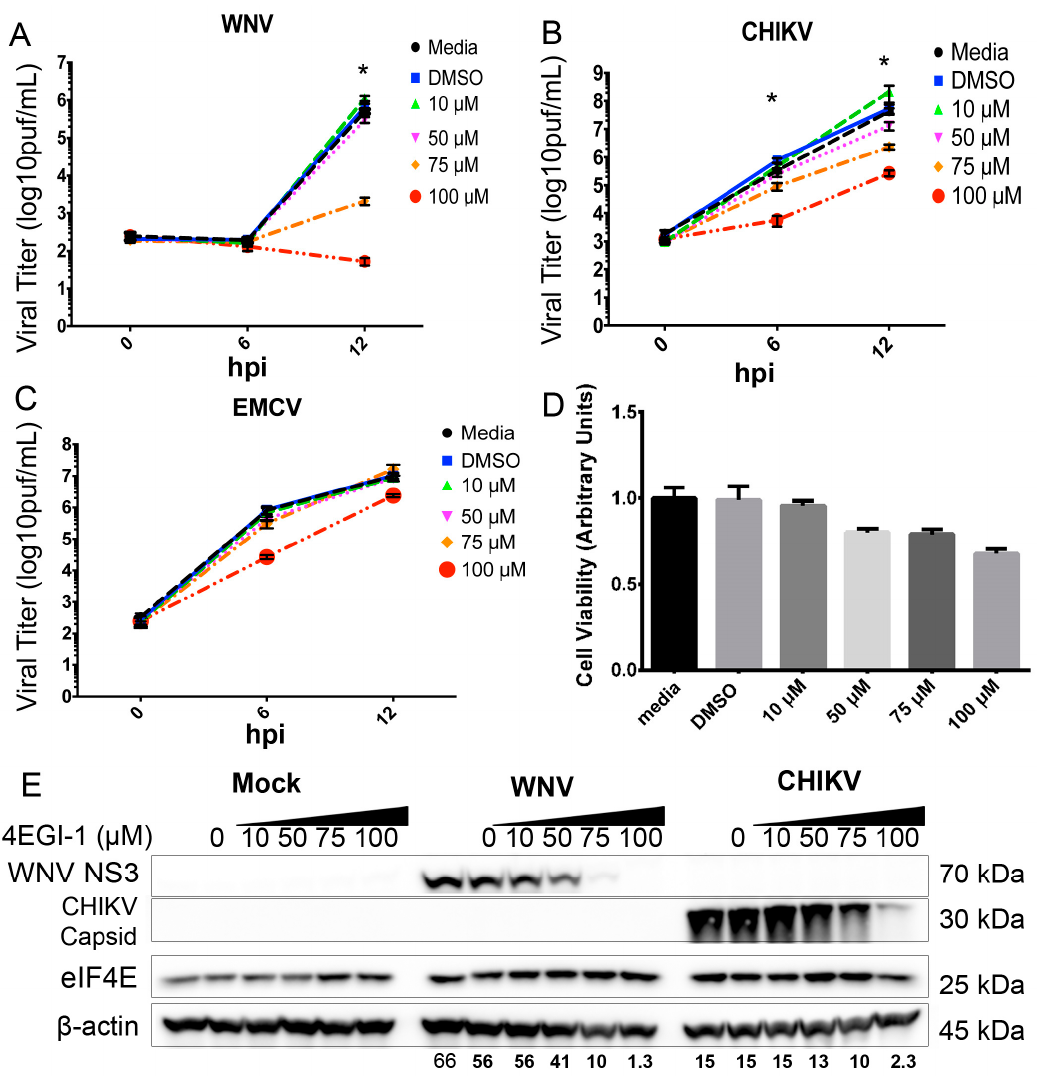
Figure 7. eIF4F complex formation supports 5 ′‐ capped positive ‐ strand RNA viral growth and protein expression. Single-step growth curves (MOI = 3) for ( A ) WNV, ( B ) CHIKV-LR and ( C ) EMCV in 4EGI-treated Vero cells as determined by standard plaque assay of supernatants. 4EGI-1 was added at the indicated micromolar ( µ M) concentrations at t = 0 hpi, and supernatants were analyzed by plaque assay at the indicated times. Viral titer data are presented as log10 plaque forming units per mL of supernatant (log10 pfu/mL). N = 9–12 replicates per time point, * p < 0.05; ( D ) MTT assay for cellular viability of 4EGI-treated Vero cells. MTT cleavage products were solubilized and measured by spectrophotometry at 570 nm. Dimethyl sulfoxide (DMSO) was used as a solvent control, and all groups were normalized to a media control of 1.0 arbitrary units; ( E ) Western blot analysis of viral protein synthesis in mock, WNV-infected (MOI = 3) and CHIKV-infected (MOI = 3) Vero cells treated with the 4EGI-1 inhibitor. Vehicle control denoted by 4EGI-1 concentration of 0 µ M. Images are representative of two independent experiments. Densitometry values provided for indicated viral proteins corrected for β -actin expression.